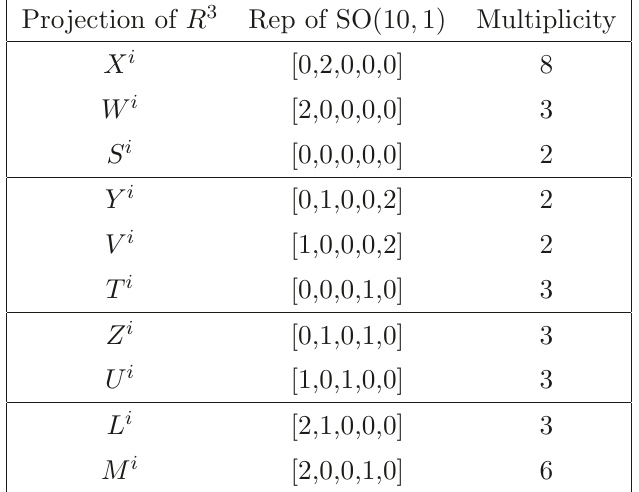
3 R in δψ . In each case, the index i runs over the corresponding ⊗